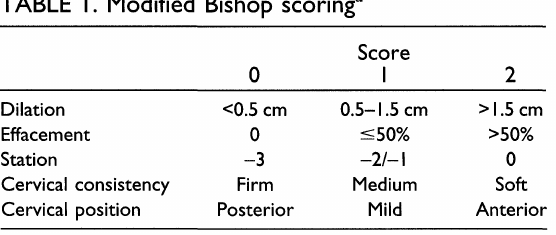
TABLE I. Modified Bishop